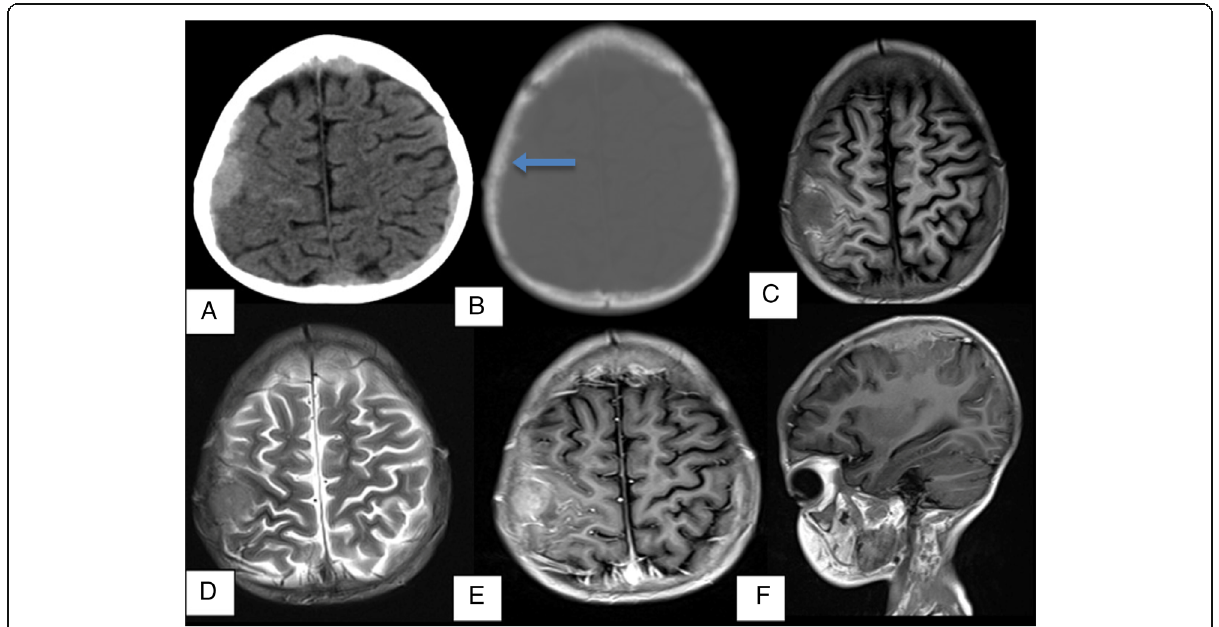
Fig. 3 CT and MRI examinations of a 6-year-old neuroblastoma patient post-autologous HSCT presenting with convulsions. a & b Axial non- contrast-enhanced CT shows bilateral irregular hyperdense meningeal thickening with underlying osseous erosions (blue arrow). c & d Conventional non-enhanced T1 axial ( c ) and T2 axial ( d ) images revealing diffuse irregular meningeal thickening mounting to extra-axial SOL formation seen eliciting intermediate signal in both T1 and T2WI sequences with related altered heterogeneous osseous signal. e & f Axial ( e ) and sagittal ( f ) T1 post-contrast images showing heterogeneous avid enhancement of the meningeal thickening and related extra-axial SOLs. Picture impressive of osseous and meningeal CNS recurrence of neuroblastoma